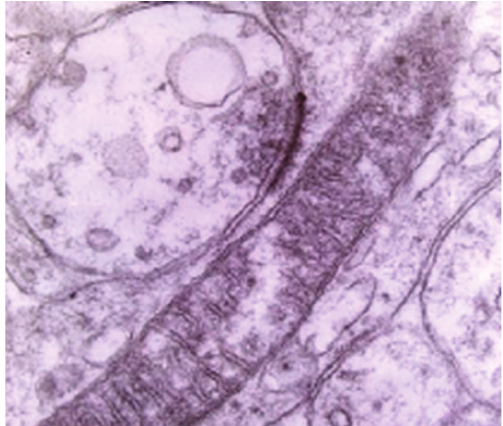
Figure 1: Dendritic profile of a Purkinje cell in a case of Alzheimer’s disease including elongated mitochondrion, showing disruption of the cristae. The presynaptic profile, presumably a terminal of par- allel fiber is characterized by the marked poverty of the synaptic vesicles (mag. 65.000x).